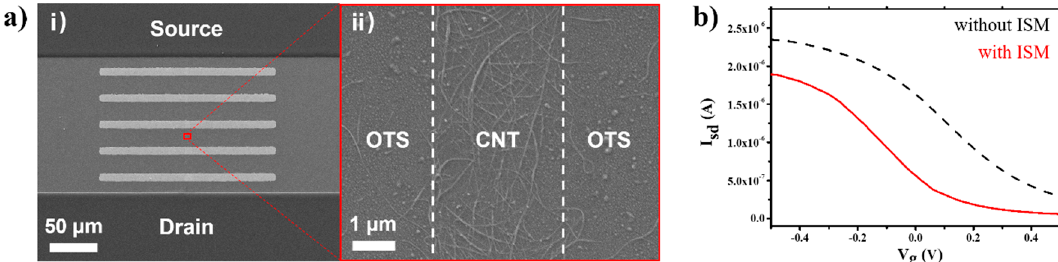
Figure 2. Characterization of an ion-selective CNT-FET with five floating electrodes. ( a ) Scanning electron microscope (SEM) images of (i) the whole channel region and (ii) the boundary of the CNT network region. ( b ) Source-drain current (I sd ) versus gate voltage (V g ) characteristics of a CNT-FET with (black) and without (red) ion-selective membrane (ISM). The CNT-FET showed p-type profiles in both cases.